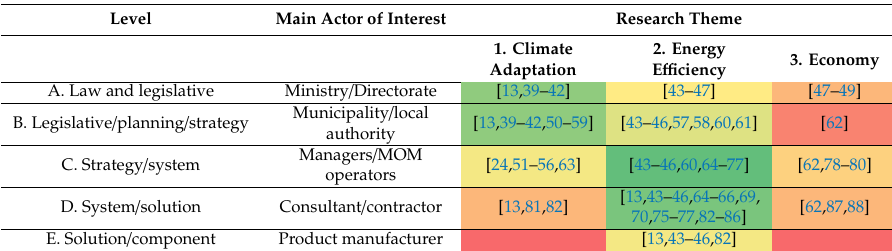
Table 4. Summary of research projects identified as being useful to this study, categorized in matrix form according to main actor and research theme. Green shading indicates cases where the topic in question is considered highly-researched. Red shading indicates that the topic has been the subject of little or no